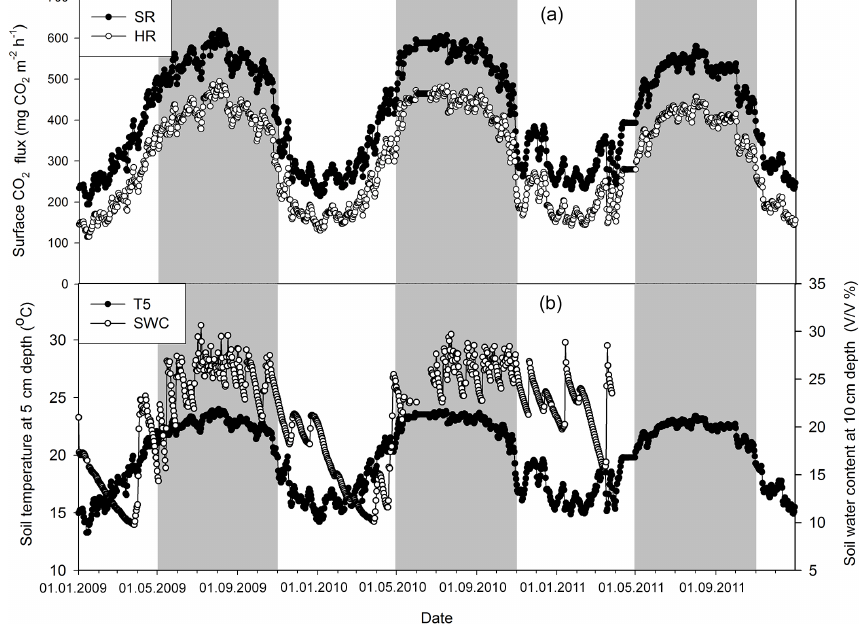
Figure 2. Dynamics of soil respiration (SR) and heterotrophic respiration (HR) (a) and soil temperature at 5cm and soil-water content at 10cm (b) in the tropical rainforest at Xishuangbanna, south-west China. The shaded area indicates the rainy season. ()